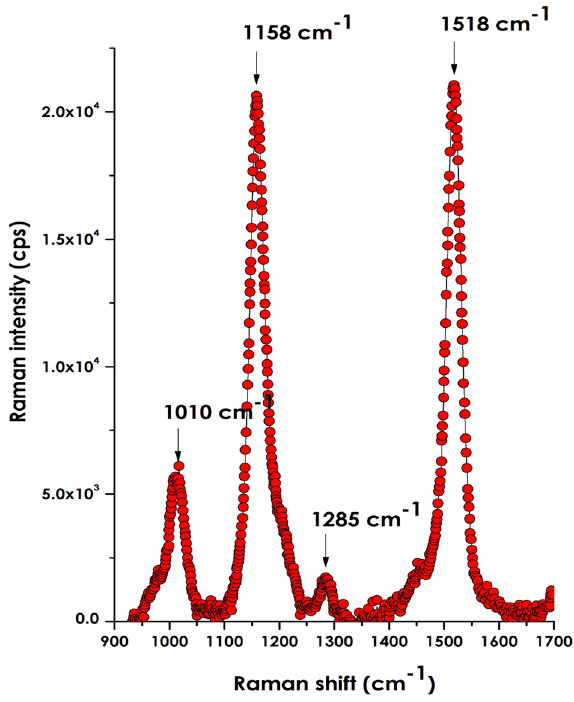
Figure 5. Raman spectrum under an argon laser excitation of 514.5 nm of Lycopene (this excitation wavelength coincides to resonance Raman conditions for